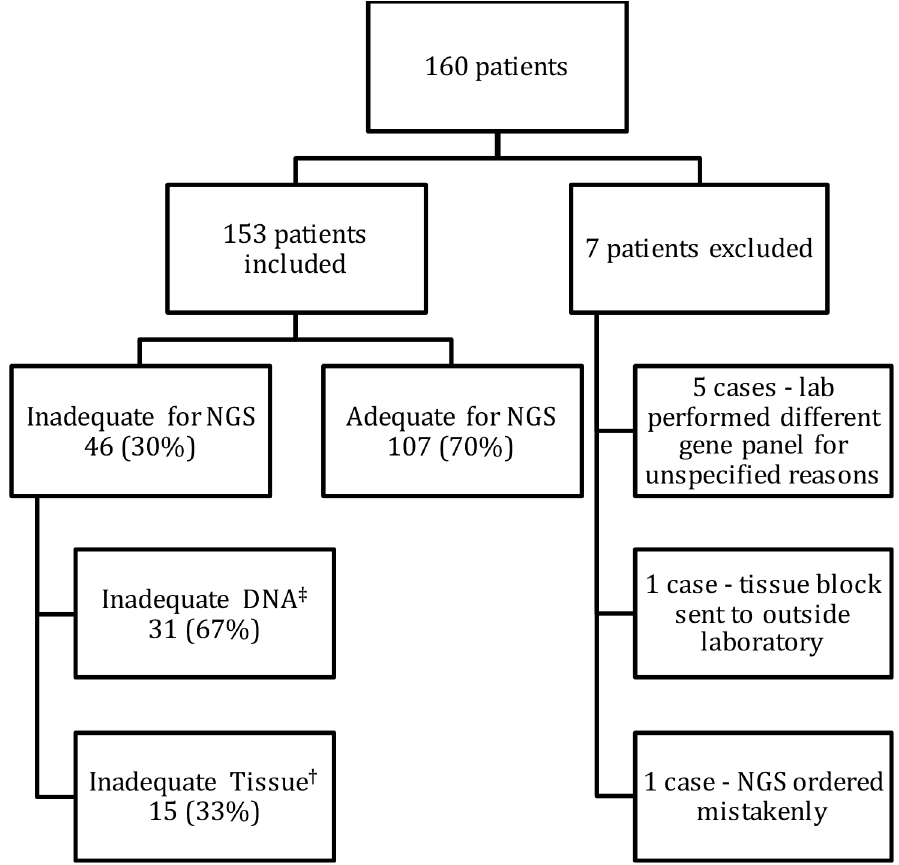
Fig 4. Patient inclusion, overall adequacy for NGS, and reason inadequate for NGS. Footnote: NGS: Next generation sequencing. a DNA quantity < 10 ng. b Less than 20% tumor cellularitydue to necrosis, fibrosis and quantity of tissue availablefor